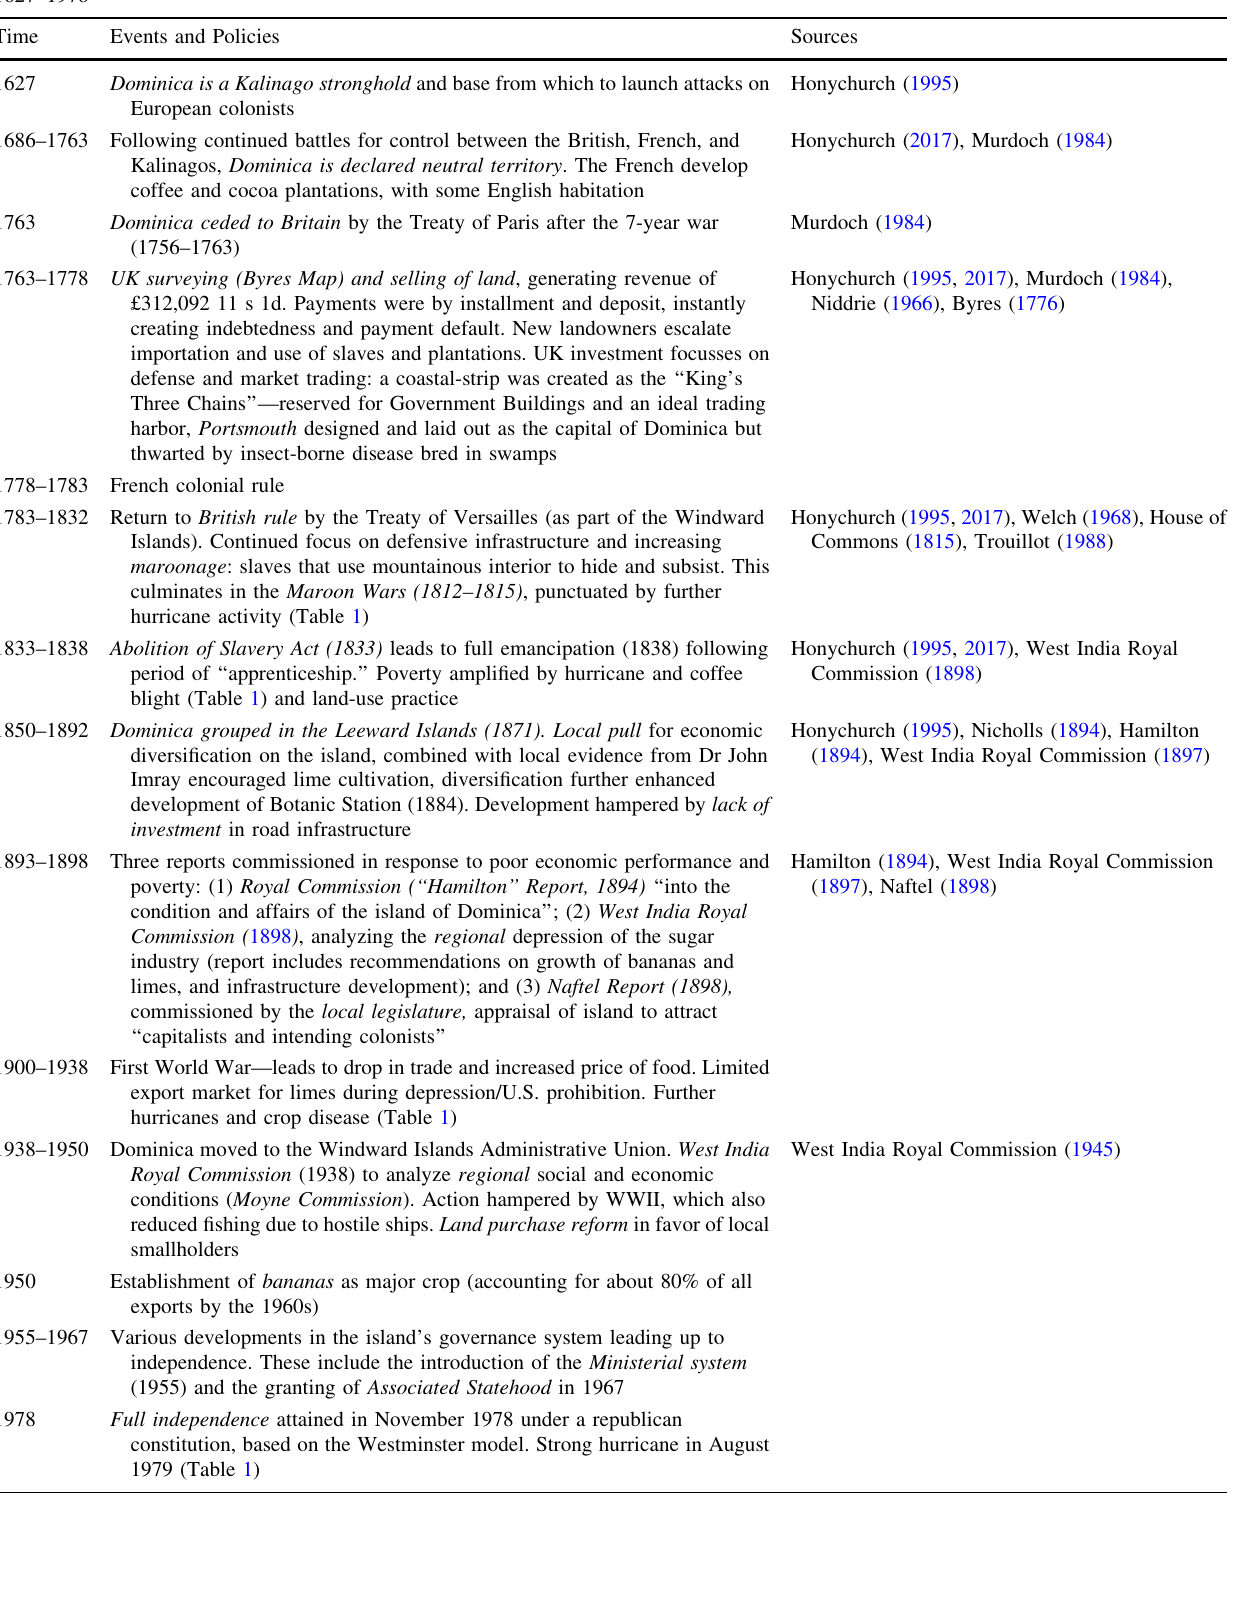
Table 2 Historical developments and policies concerning land use, infrastructural development, governance, and social attitudes in Dominica,